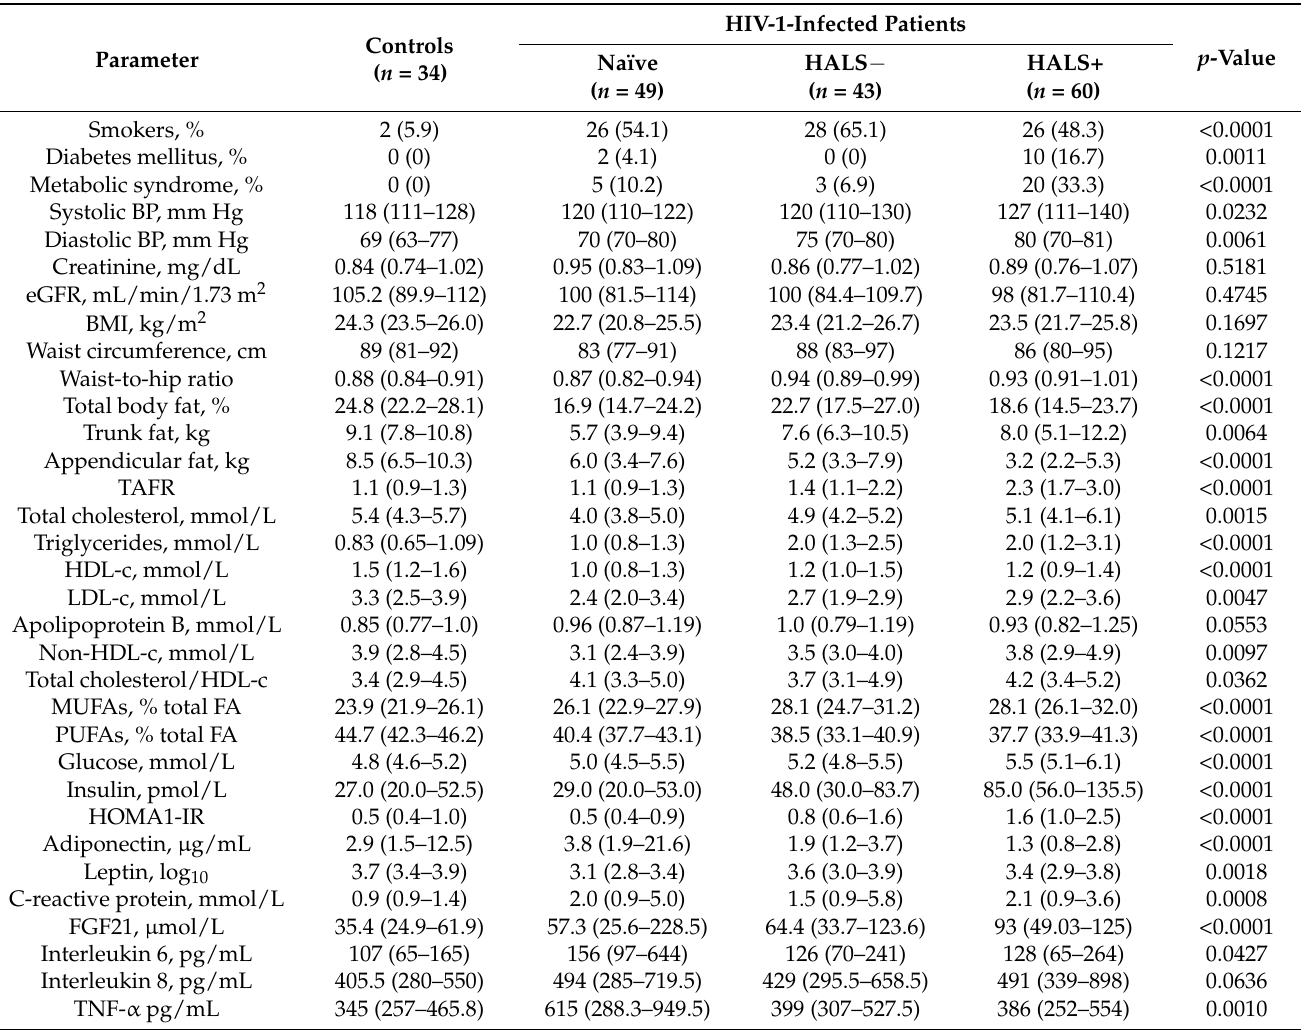
Table 2. Anthropometric, cardiovascular risk factors, metabolic and fat parameters, and cytokine